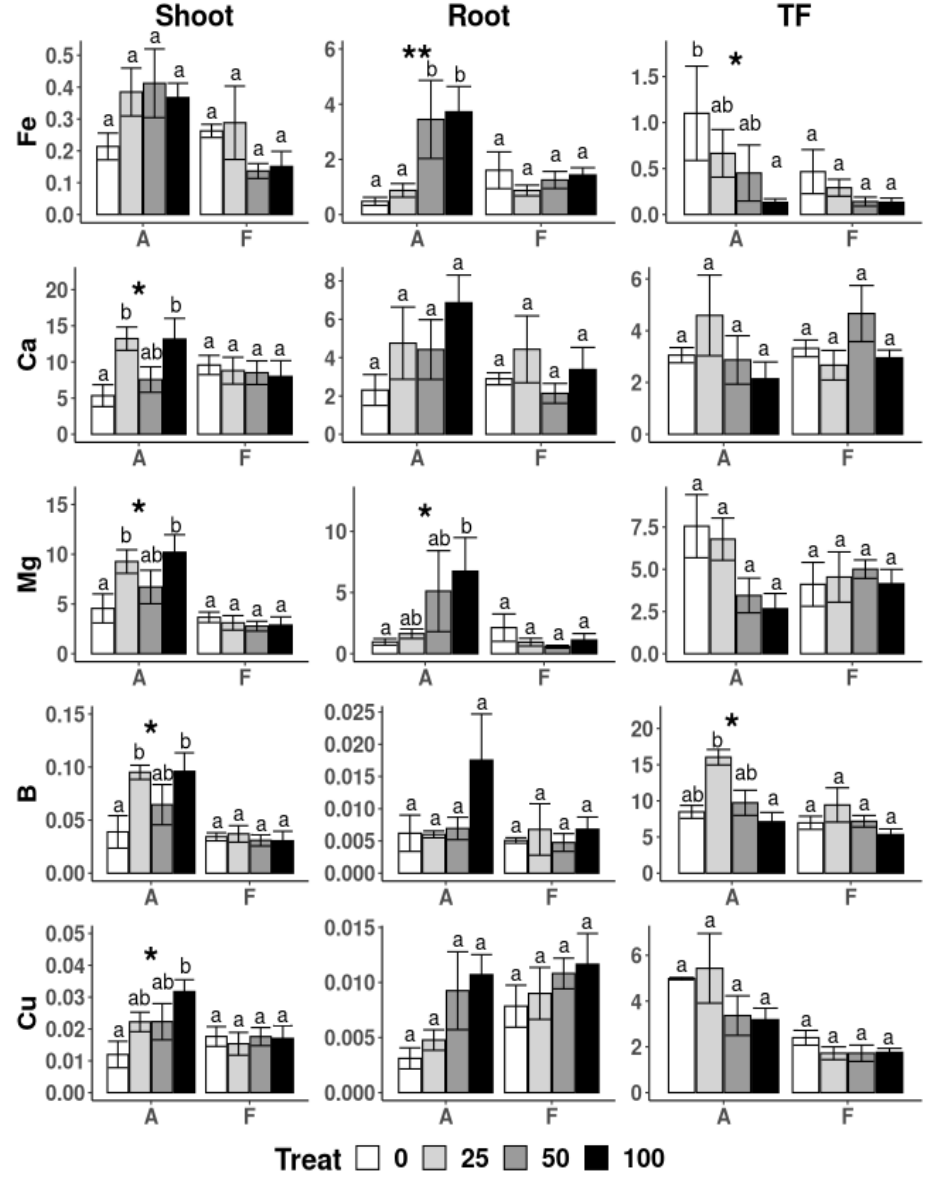
Figure 5. Translocation Factor (TF) and uptake of elements (g) in shoot and root biomass of A. capillaris (A) and F. rubra (F) at the end of the hydroponic experiment for the different treatments (e.g., 0, 25, 50 and 100 mg nZVI L − 1 ). For the one-way ANOVA * p < 0.05, ** p < 0.01, no asterisks for p > 0.05. Different letters above the bars represent significant differences according to Tukey′s test at p < 0.05.